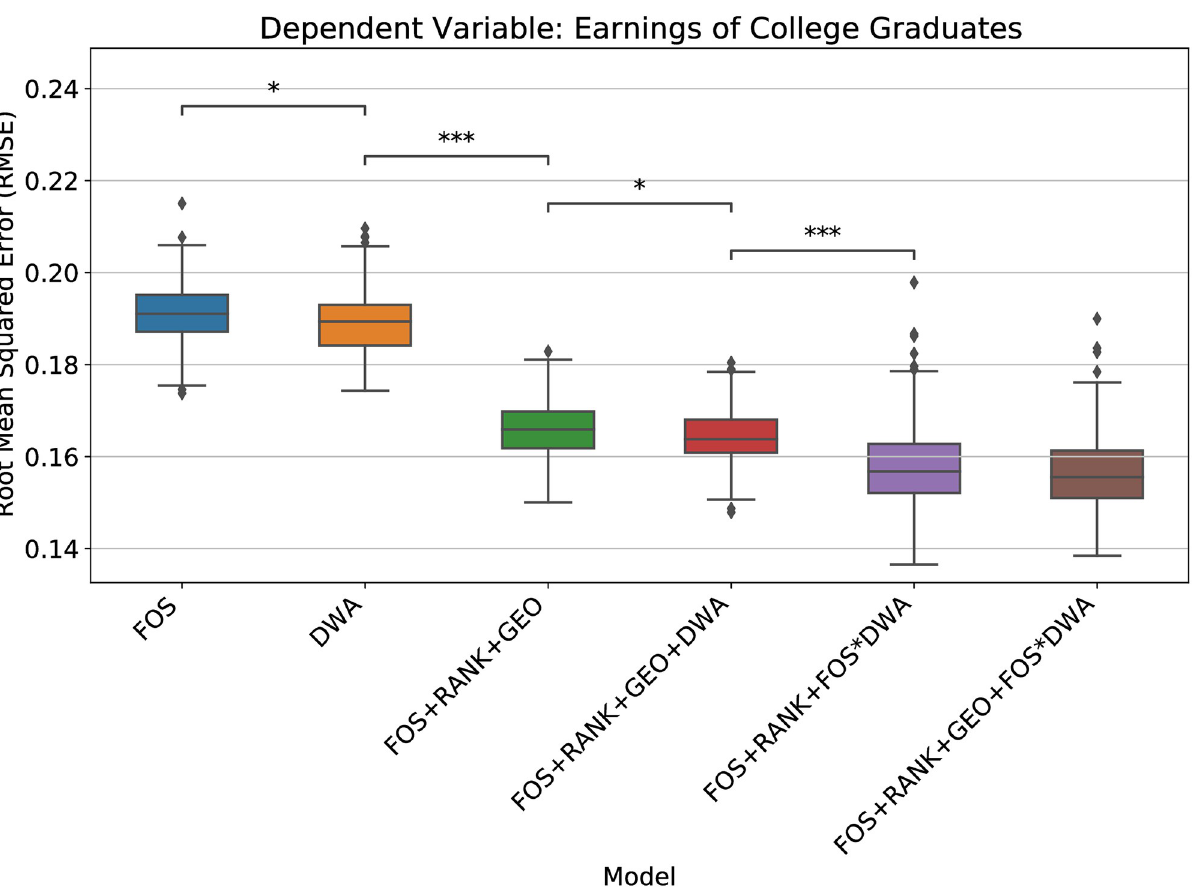
Fig 5. Workplace activities detected from syllabi predicting median first-year earnings of college graduates across fields of study. We perform 5-fold cross validation and repeat 40 times (i.e., 200 trials in total) for each model and measure RMSE by the resulting model applied to the test set. Asterisks indicate the statistically significant difference between two models’ performances with Bonferroni correction. As a baseline, we consider the FOS, school ranking, and geographic fixed effects to predict earnings.